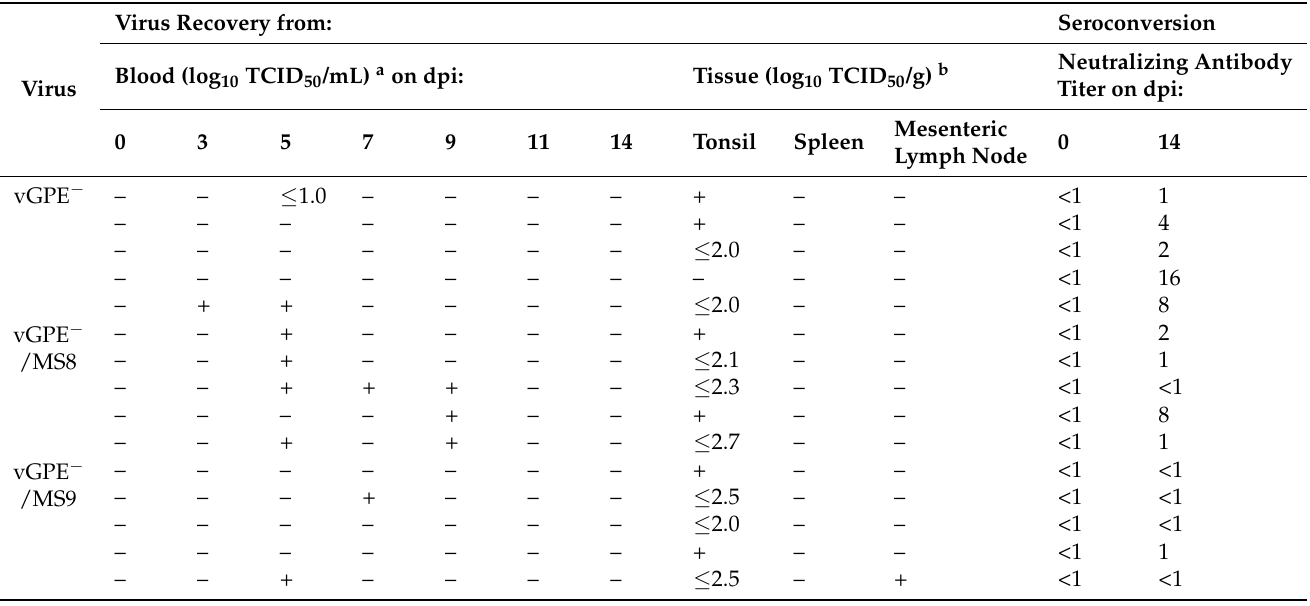
Table 2. Virus recovery from and seroconversion in pigs infected with vGPE − and seed variants. Virus Recovery from: Seroconversion Blood (log 10 TCID 50 /mL) a on dpi: Virus